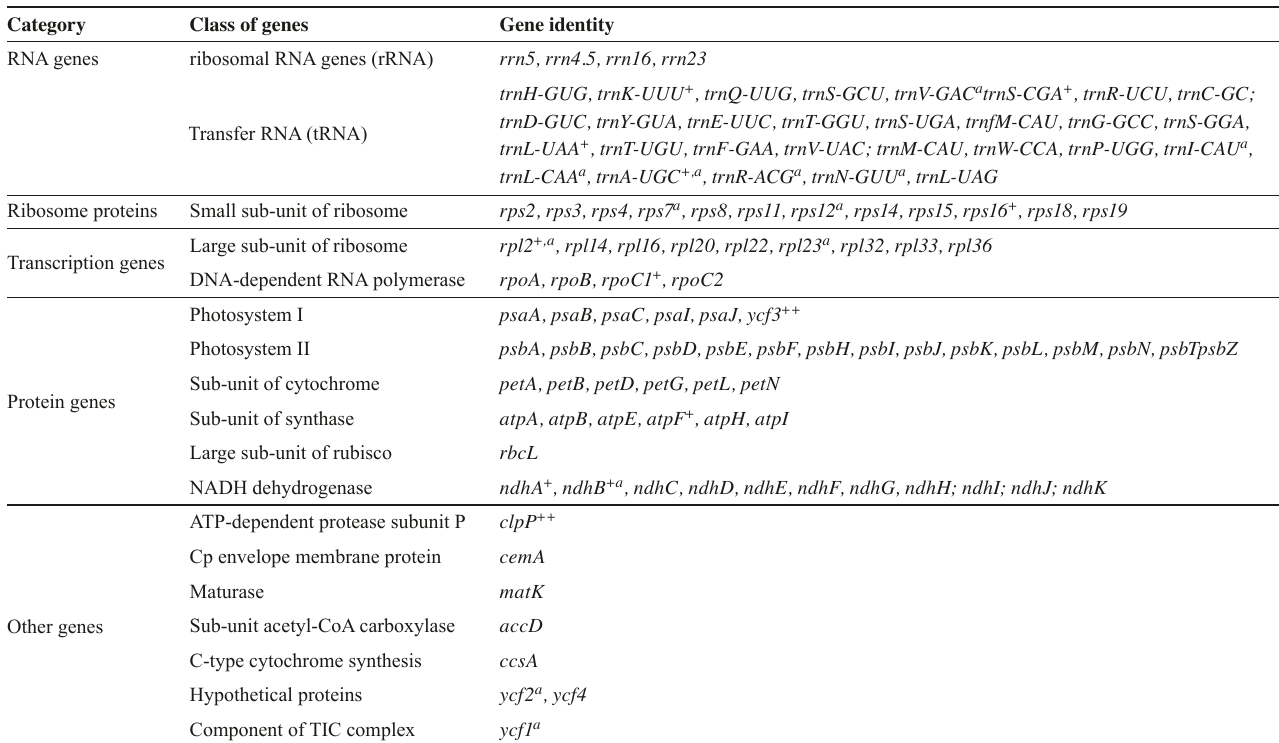
Tab. 4: Genes present in the Caralluma quadrangula cp genome.